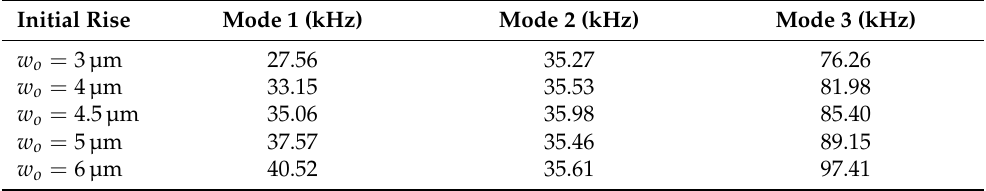
Table 4. The natural frequencies of the arch microbeam actuated with a half-electrode and V DC = 15V.